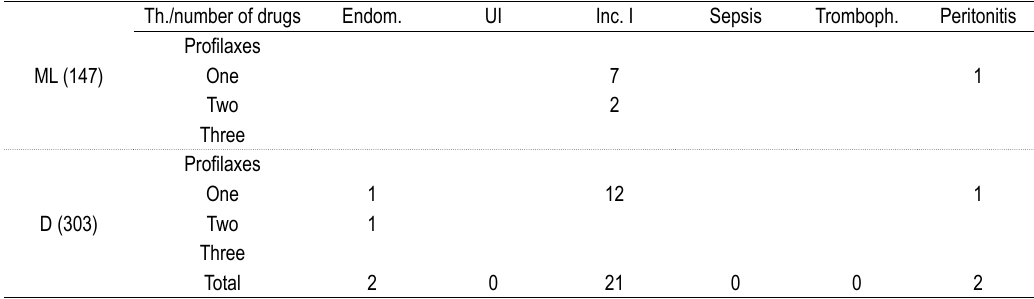
Table 2. Inflammatory complications after Caesarean